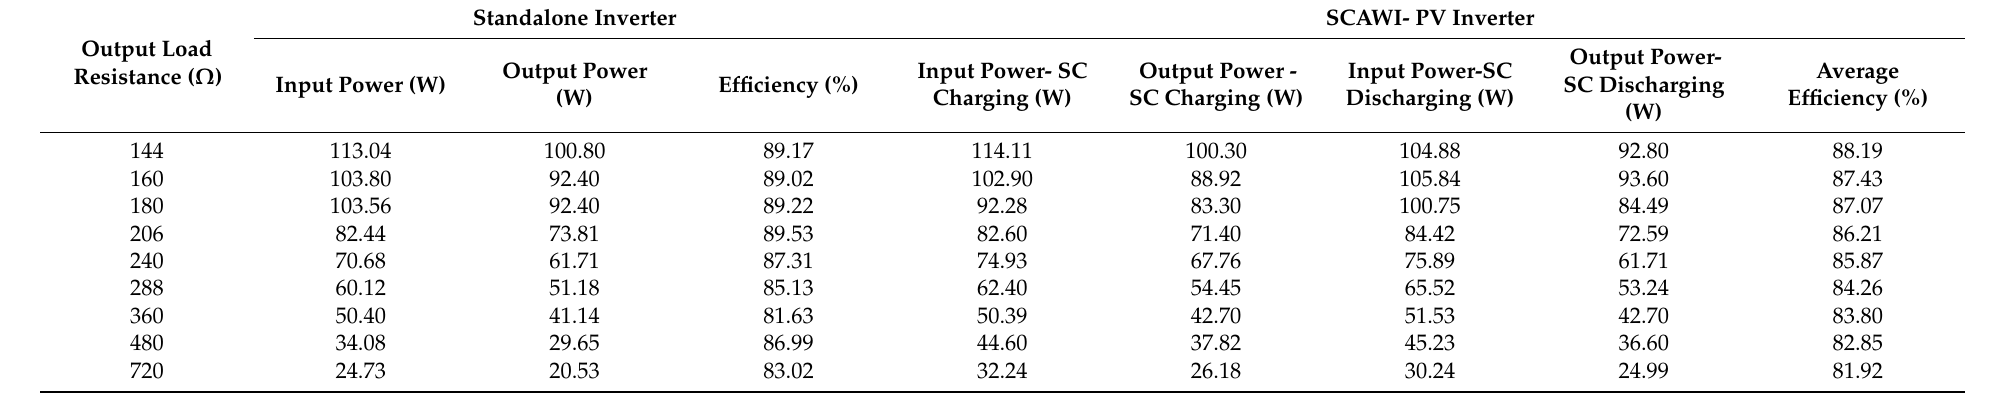
Table 4. End-to-End Efficiency of the SCAWI-PV technique compared to the standalone 12 VDC–120 VAC